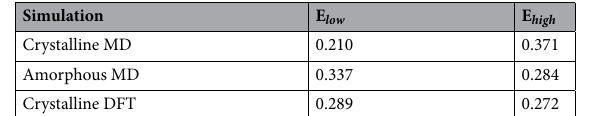
Table 1. Weighted least squares error for the comparisons of the three simulations to the experimental data. E 1 –3500 cm − ,